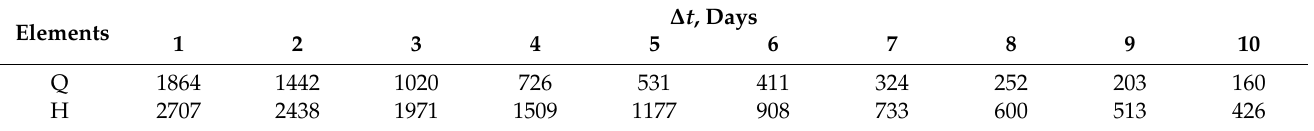
Table 4. The number of stream gauging stations with good forecasts of various lead